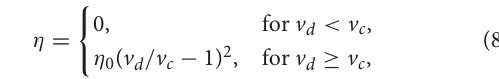
FIGURE 1 | TWIKH vortices throughout, for a loop without initial boundary layer and no viscosity. From top to bottom rows we have the cross-section at the apex of the loop of, respectively, the total number density (in units of 10 9 cm − 3 ), the temperature ( log T ), the flow velocity (in km s − 1 ), the z the z current density component (in cgs units). The 3 columns, from left to right, show 3 instances in time, respectively at t − t 2,334 s 7.4 P , where P 315 s is the period of the kink mode. The half ellipse in white (or black in the flow velocity panels) corresponds to the ellipses = ≈ = calculated in section 3.2. See also the accompanying movie in the Supplementary Material